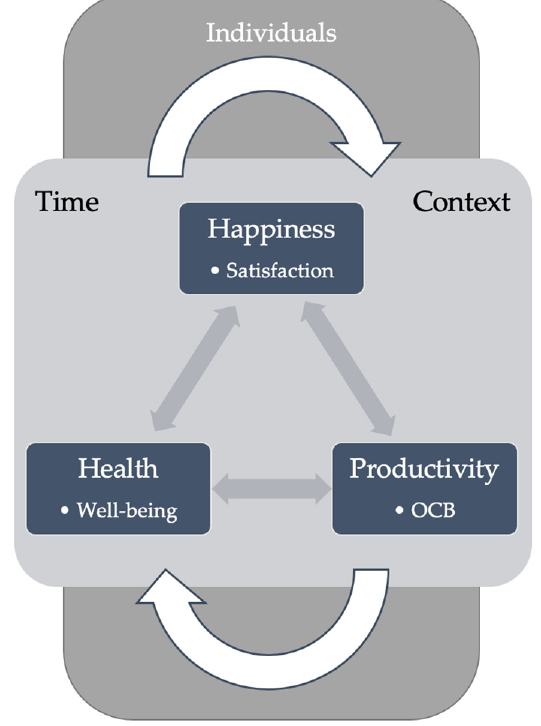
Figure 1. Individual Sustainable Career Process (adapted from De Vos et al. [1]).